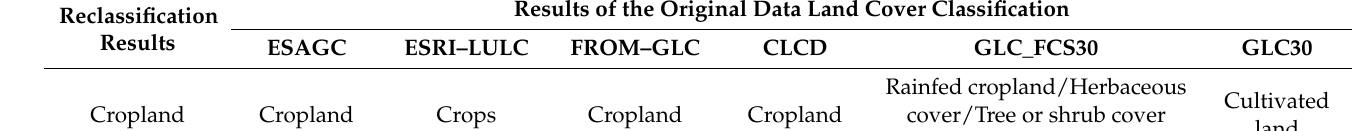
Table 2. Table showing correspondence between land cover classes after reclassification and the original classes used for the six land cover